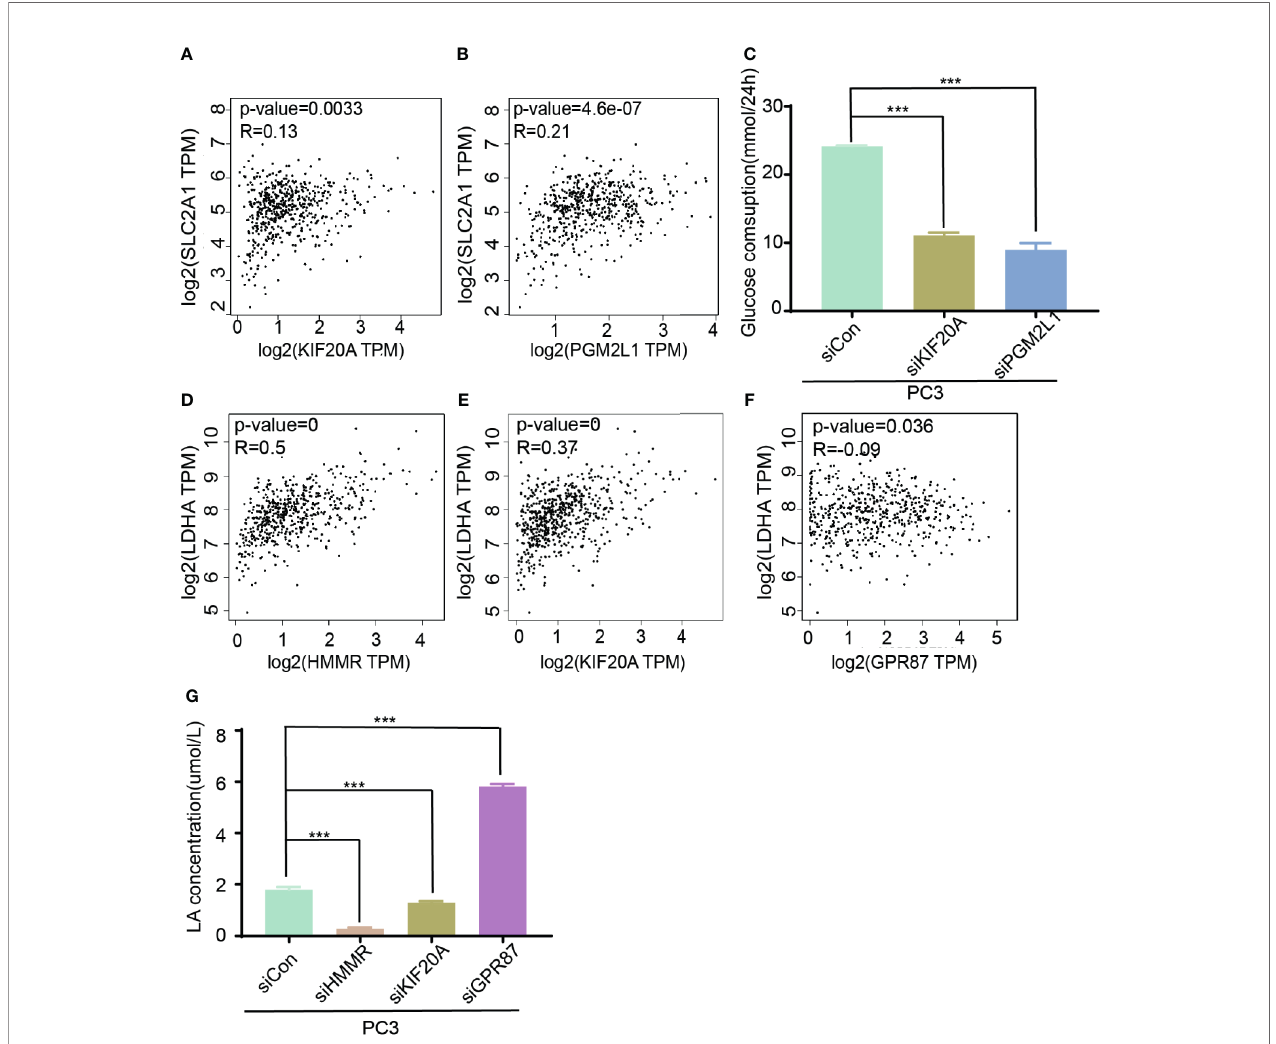
FIGURE 6 | Molecular function of fi ve genes in glycose consumption and lactic acid production. (A, B) Analysis of corrections of SLC2A1 with KIF20A (A) or PGM2L1 (B) . (C) Detection of glucose consumption in control or siRNA (KIF20A and PGM2L1) group. *** p < 0.001. (D – F) Analysis of correction of LDHA with HMMR (D) , KIF20A (E) , and GPR87 (F) . (G) Investigation of lactic production in control and siRNA (HMMR, KIF20A, and GPR87) group. *** p <